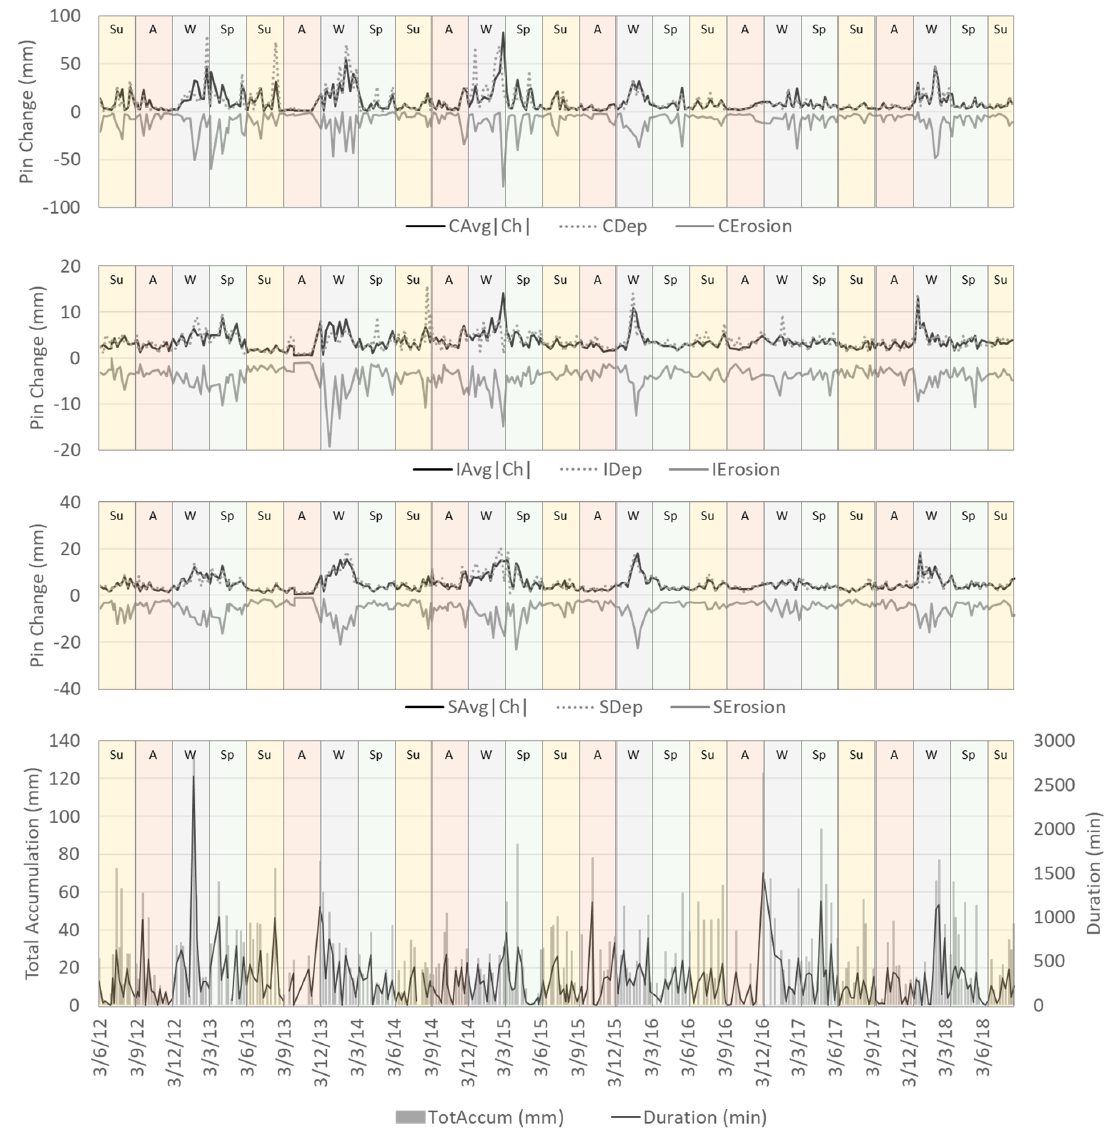
Figure 3. Comparison of erosion variables by geomorphic area. The top three graphs show erosion in channels (C, top), interfluves (I, middle), and sidewalls (S, lower), bottom graph shows precipitation. Columns mark seasons (Su = summer, A = autumn, W = winter, and Sp = spring).